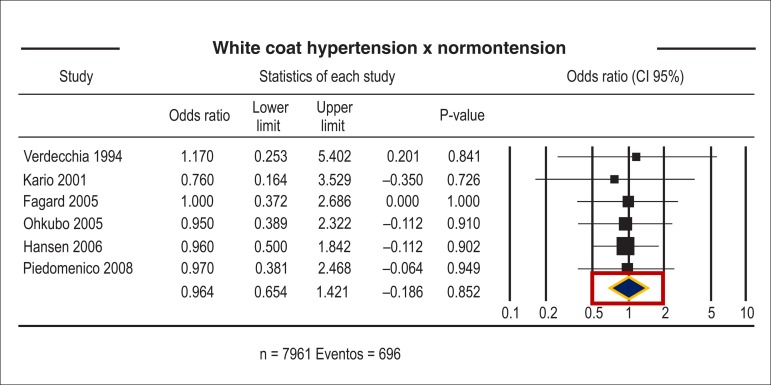
Odds ratio of patients with white coat hypertension compared with
normotensive patients.34